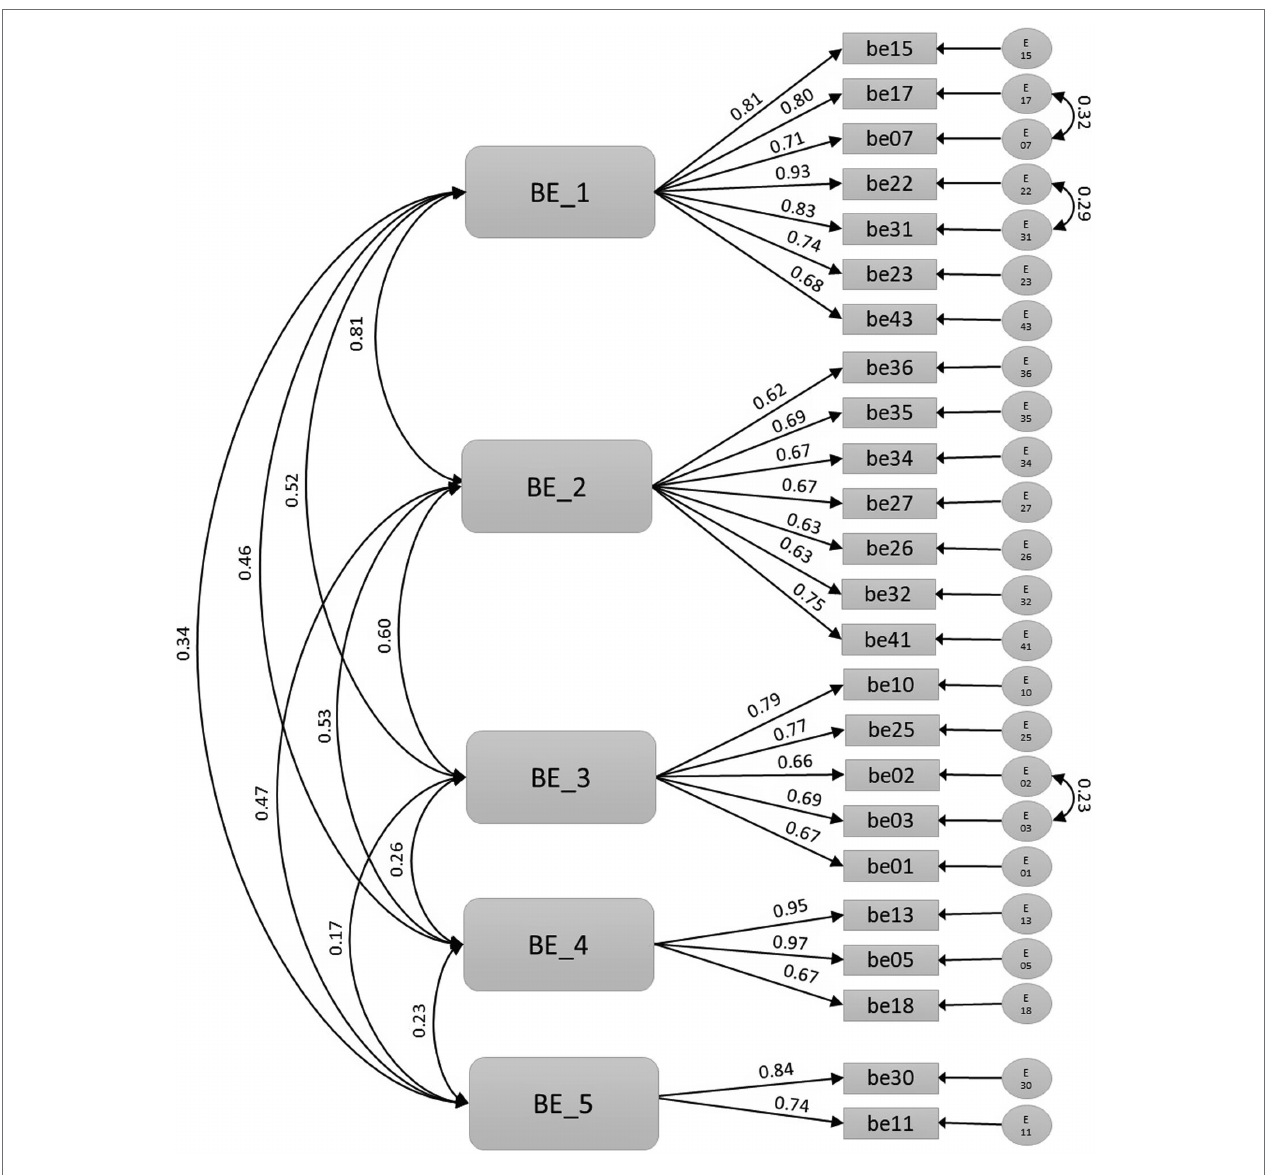
FIGURE 2 | Barrier factors’ measurement